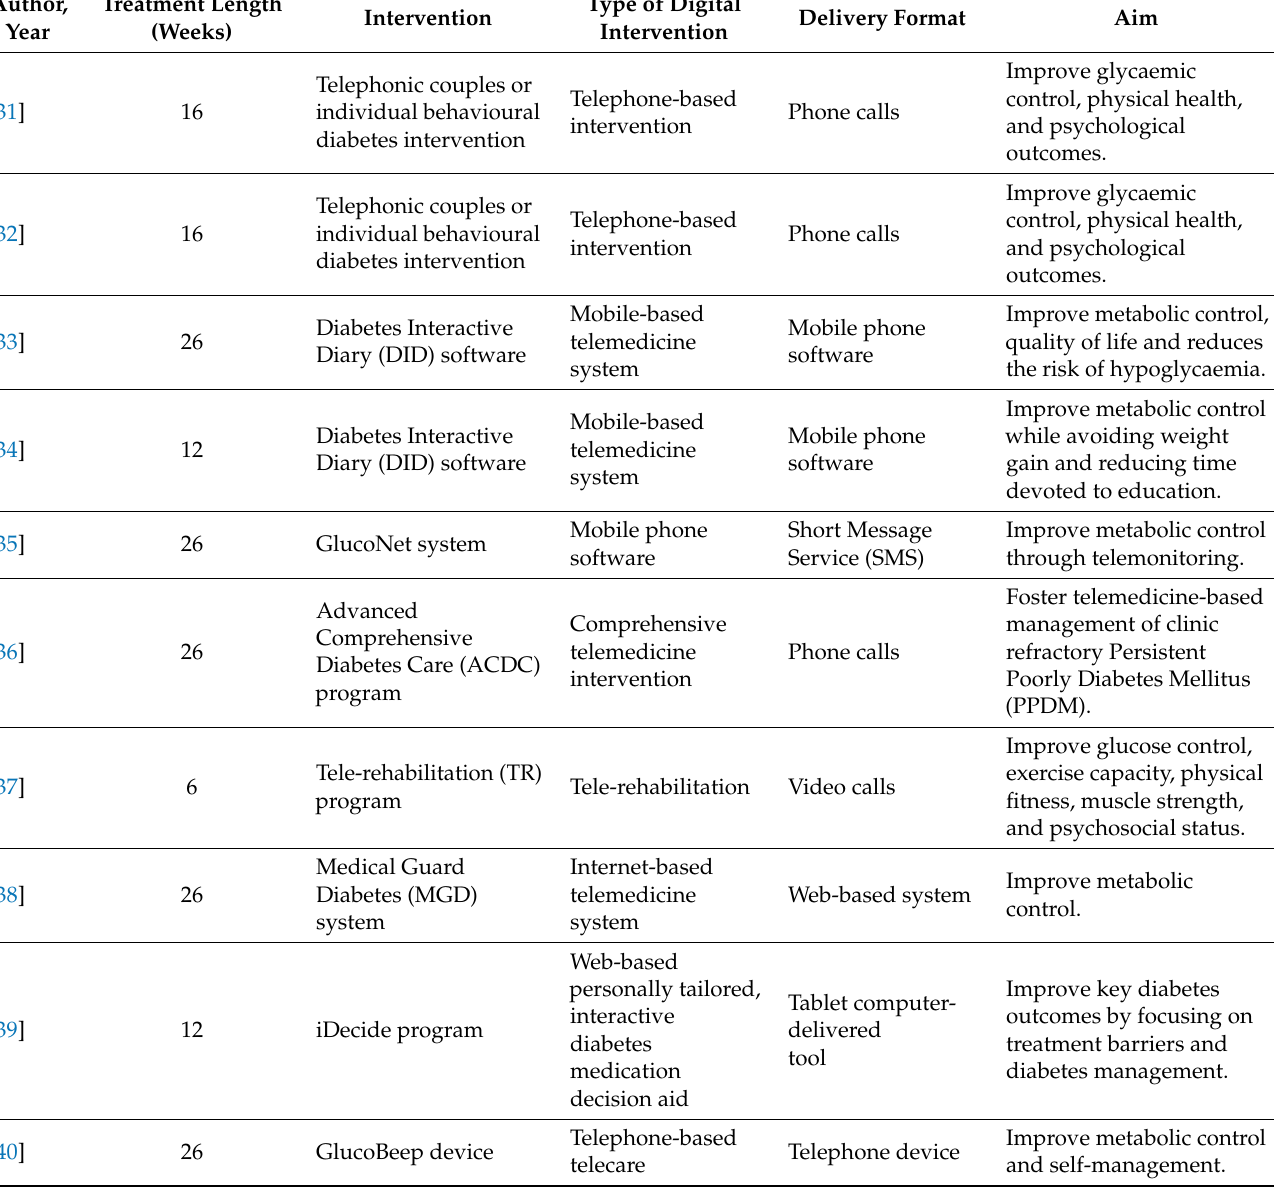
Table 2. eHealth Interventions’